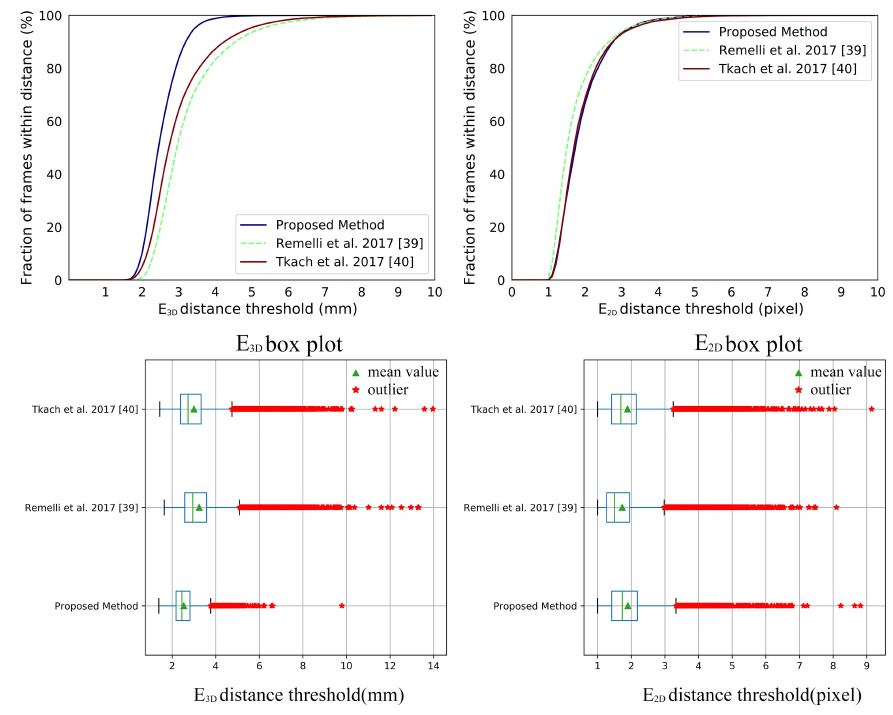
Figure 18. The E 3 D and E 2 D total results of comparison between our system with Remelli et al. [39] and Tkach et al. [40] on Handy/GuessWho